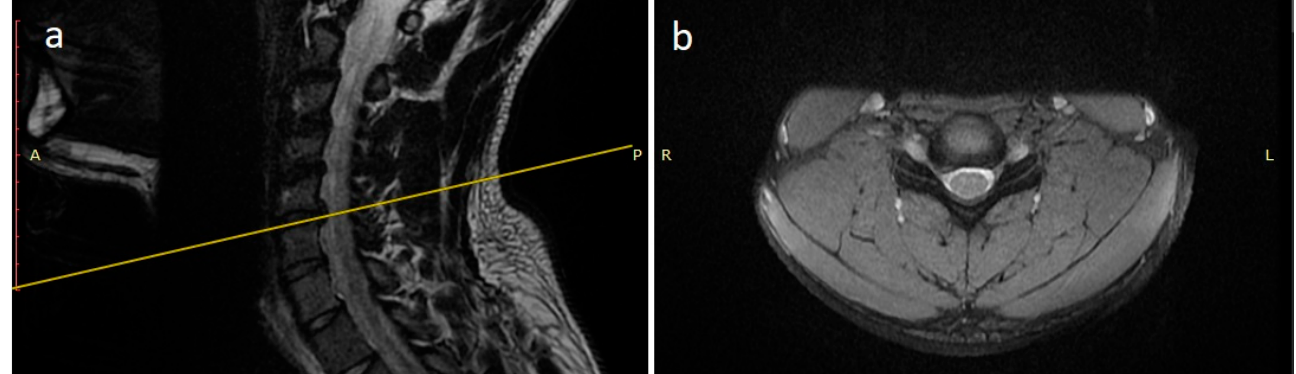
Figure 2. MRI scan sagittal ( a ) and coronal ( b ) images of the cervical spine showing a C5-C6 disc herniation with C6 root compression.